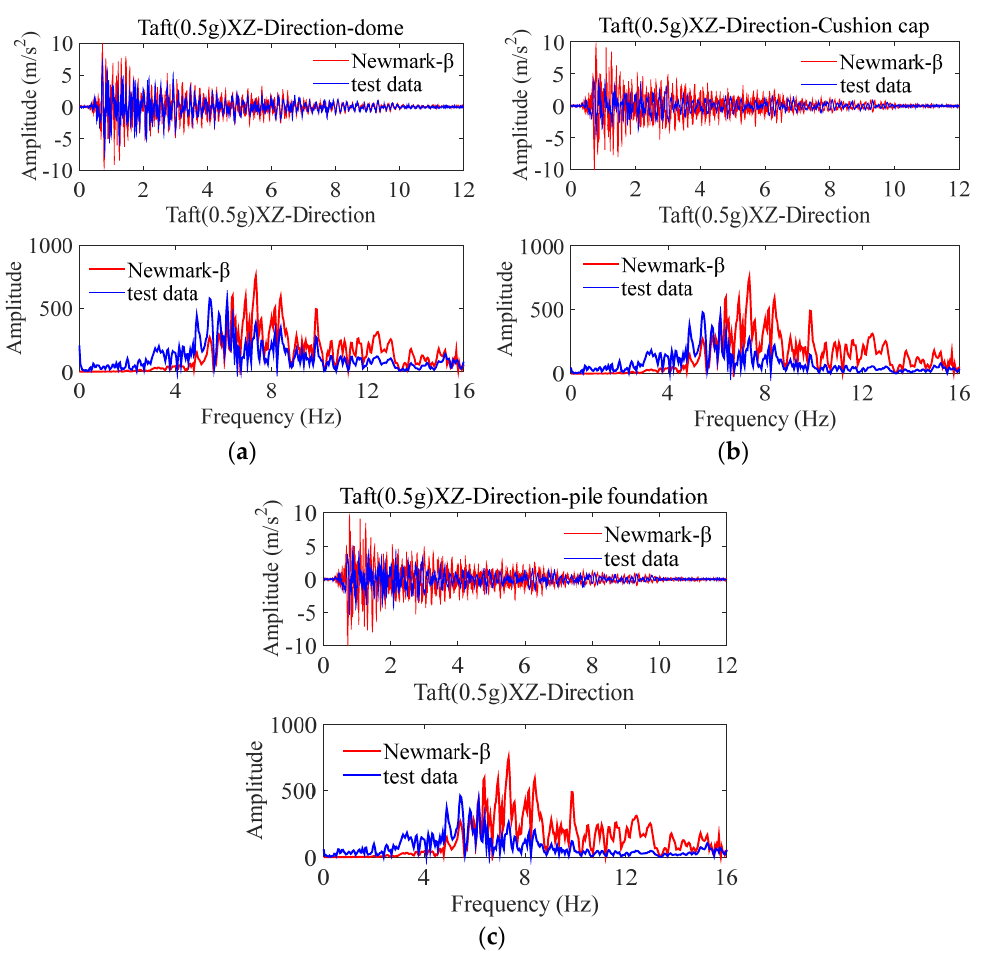
Figure 14. Comparison of shaking table test data and theoretical solutions under the Taft wave: ( a ) dome acceleration time history and spectrum comparison; ( b ) cushion cap acceleration time history and spectrum comparison; ( c ) pile foundation acceleration time history and spectrum comparison.